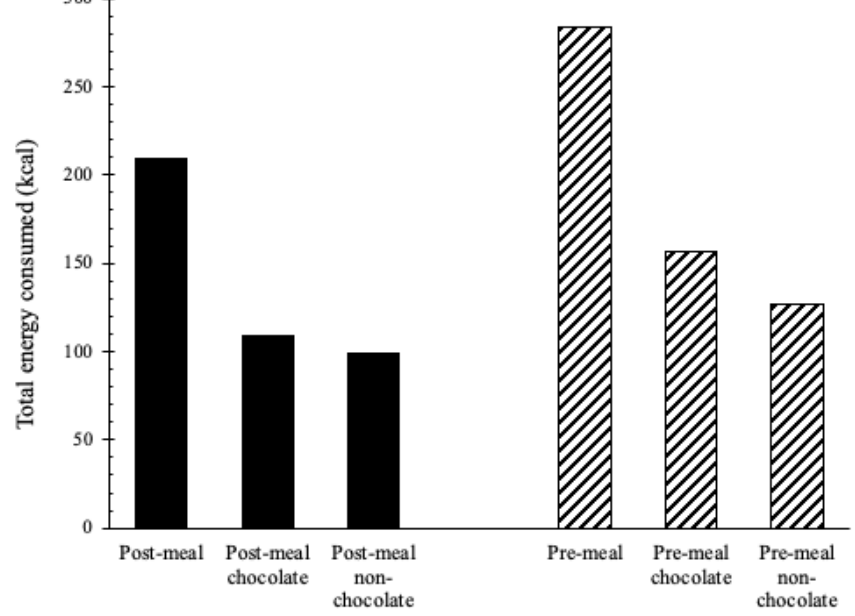
Figure 2. Children’s total energy (kcal) from candy intake during the pre- and post-meal conditions by child sex and candy type ( n = 38). Chocolate candies = M&Ms, Hershey’s Nuggets, Snickers Miniatures candy bars, Kit Kats Miniatures chocolate bars, Reese’s Peanut Butter Cups miniatures. Non-chocolate candies = SweeTarts, Haribo Gold-Bears Gummi Candy, Skittles, Swedish Fish, Goetze’s Caramel Creams, and Dum Dum